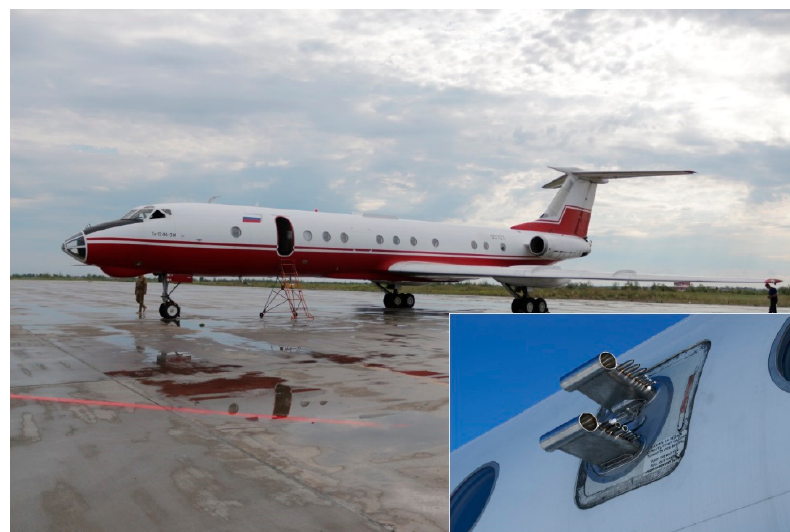
Figure 2. Photo of Tupolev-134 aircraft. Insert is the samplers’ Inlets.